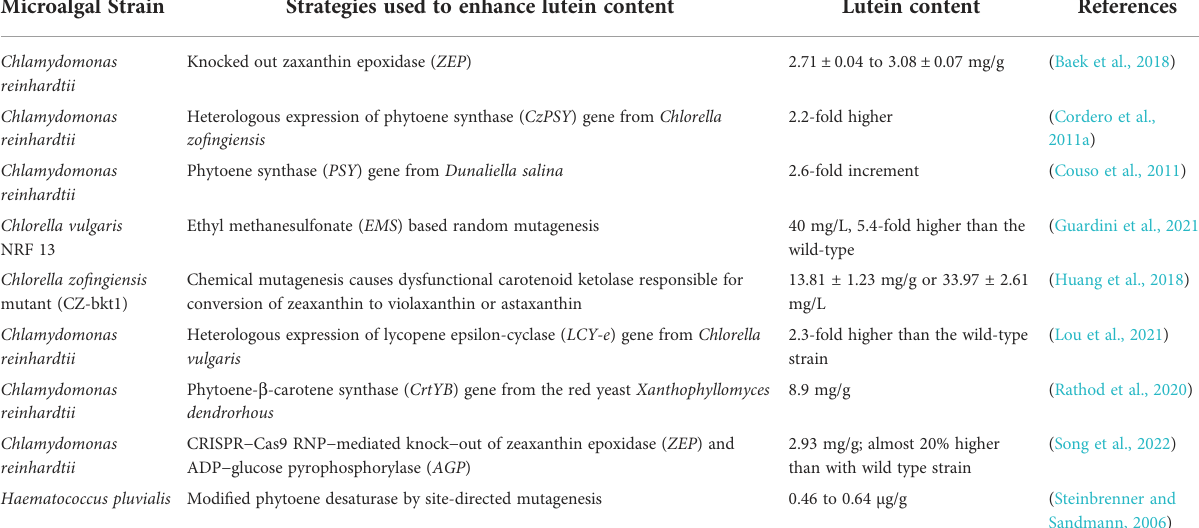
TABLE 1 Genetically modi fi ed microalgal strains for enhanced lutein